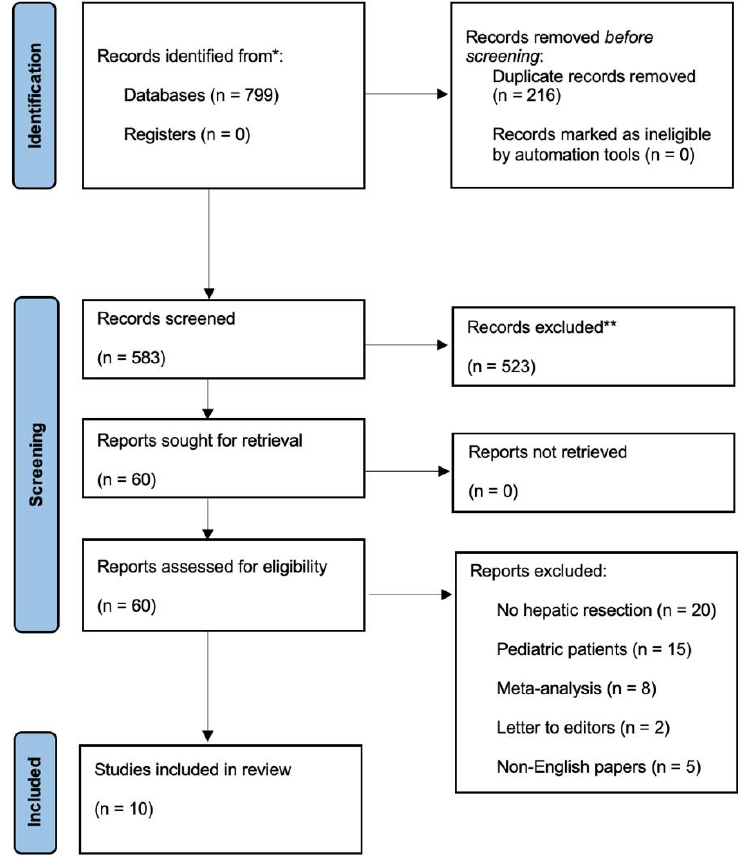
Figure 1. PRISMA flow chart for the selected studies included in the systematic review (* records identified from Pubmed, Embase and Cochrane database in total, ** records excluded by two different reviewers)